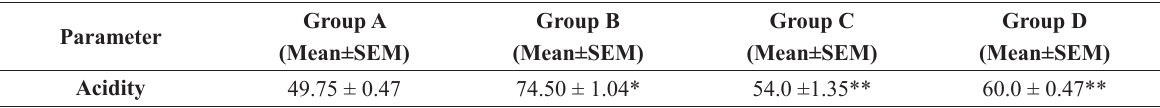
Determination of total acidity of gastric contents from negative control (group A), positive control (group B), standard drug control (group C) and extract treated group of rats (* P <0.05; compared to negative control group, ** P <0.05 compared to positive control group; n=5).